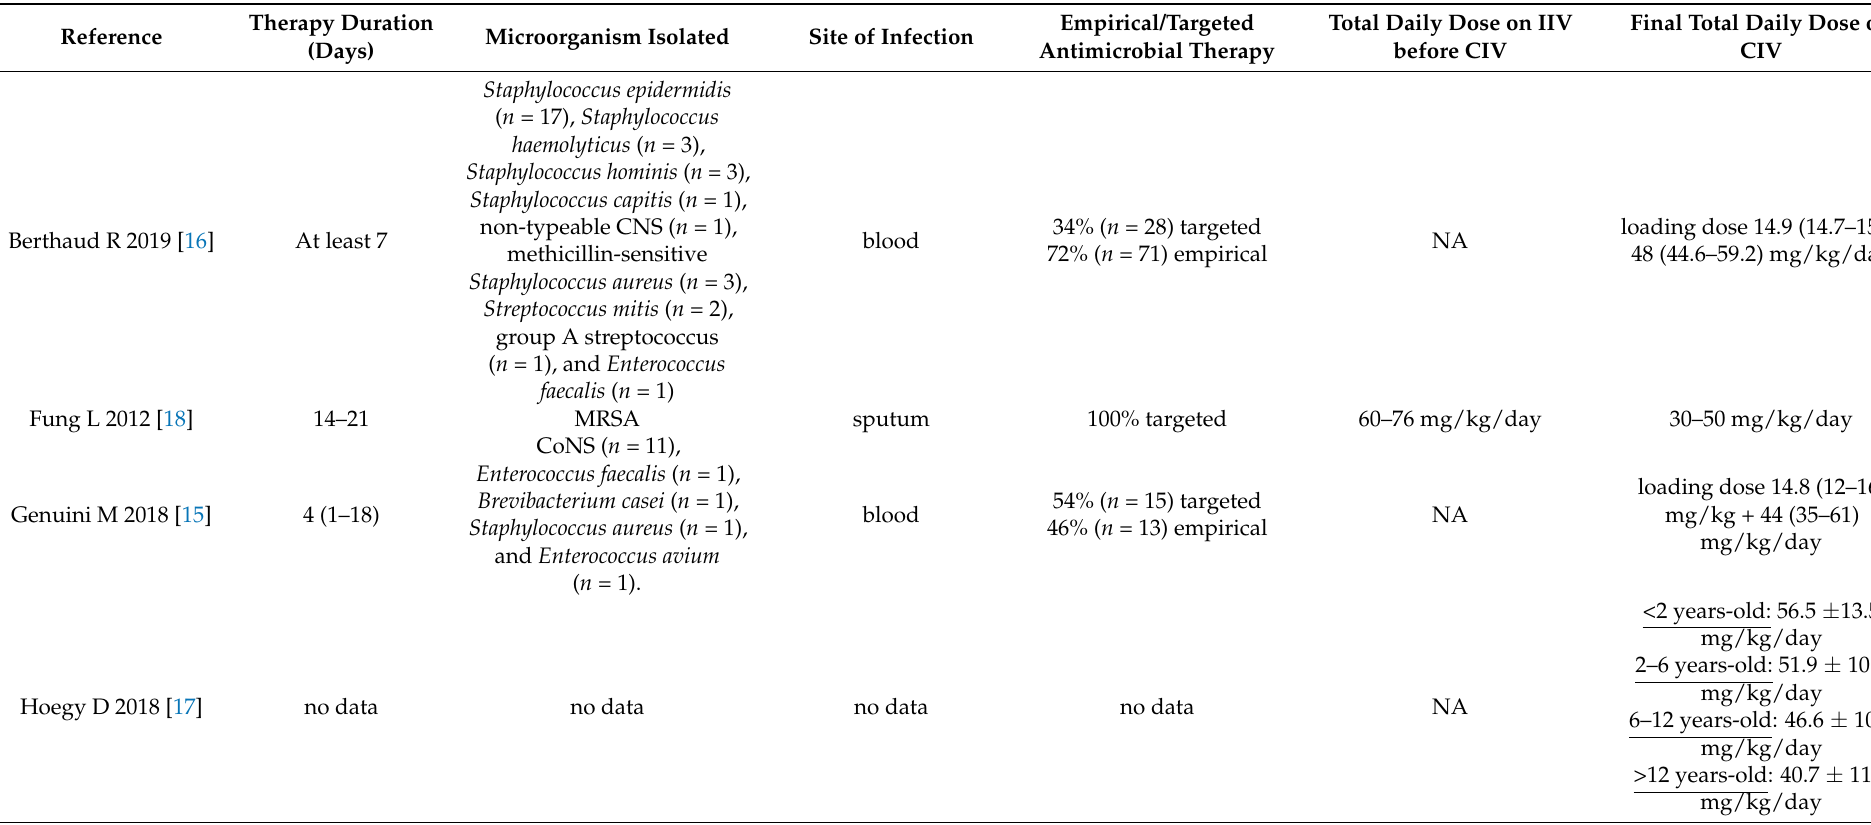
Table 3. Characteristics of vancomycin treatment